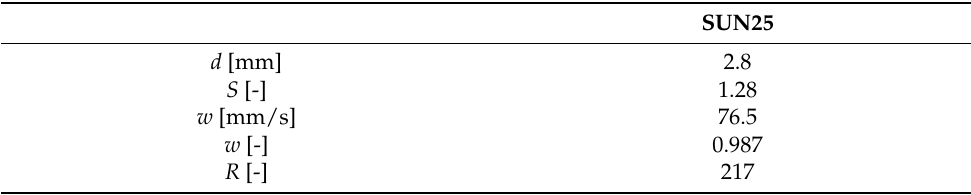
Table 1. Properties of tested solids: Particle equivalent diameter d , specific gravity S , terminal settling velocity w , particle Reynolds number R .